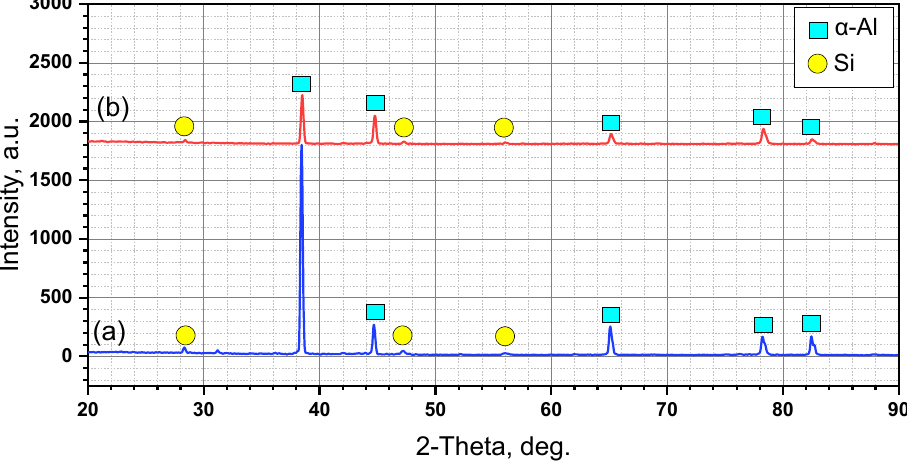
Figure 7. XRD patterns of ( a ) as-cast A356 and ( b ) AMP deposited at 1200 rpm and 3 mm/min.